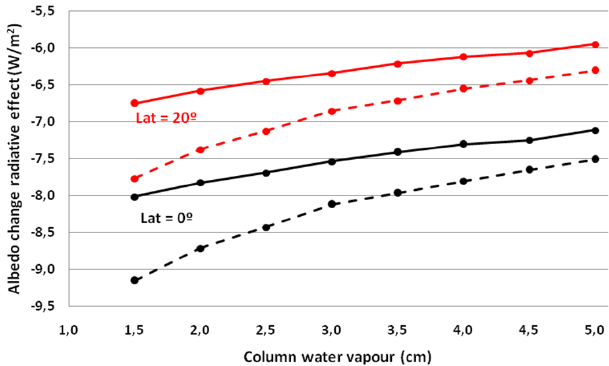
Fig. 8. Albedo change radiative effect as a function of water vapour amount in the atmosphere before deforestation. Black and red lines indicate the results over sites located at latitude = 0 ◦ and at lati- tude = 20 ◦ , respectively. Solid lines represent the effect, assuming equal water amounts before and after deforestation. Dashed lines represent the effect, assuming the deforested region is 0.35cm drier after